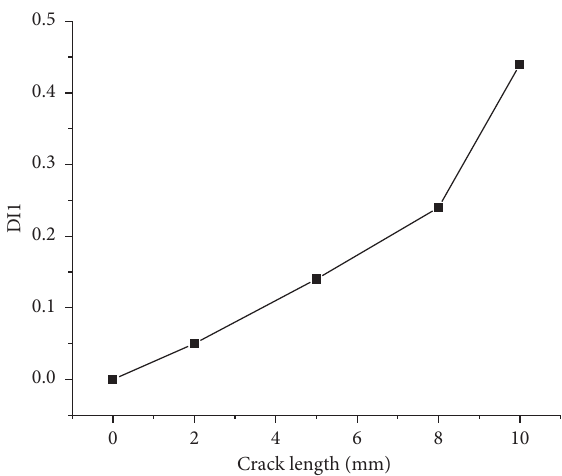
Figure 6: Damage index DI1 versus the crack lengths [34].